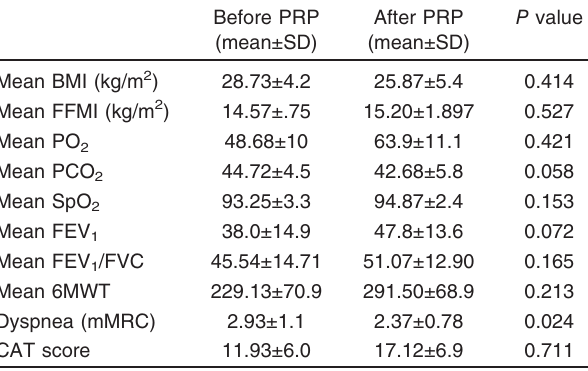
Table 3 Statistical comparison between different variables in the muscle-depleted group before and after pulmonary rehabilitation program Before PRP (mean±SD)